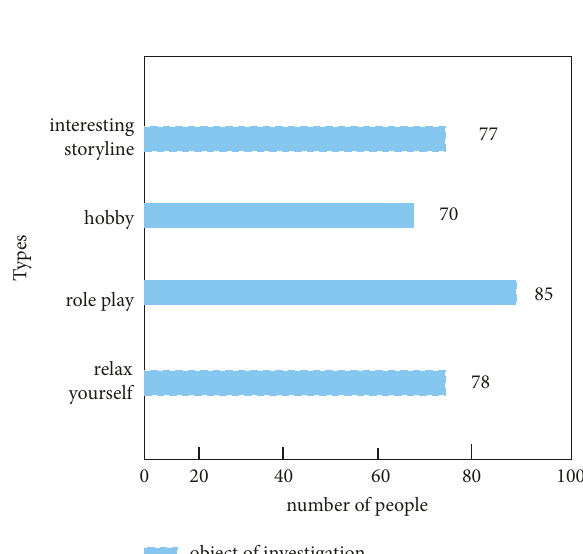
Figure 9: Reasons to love anime